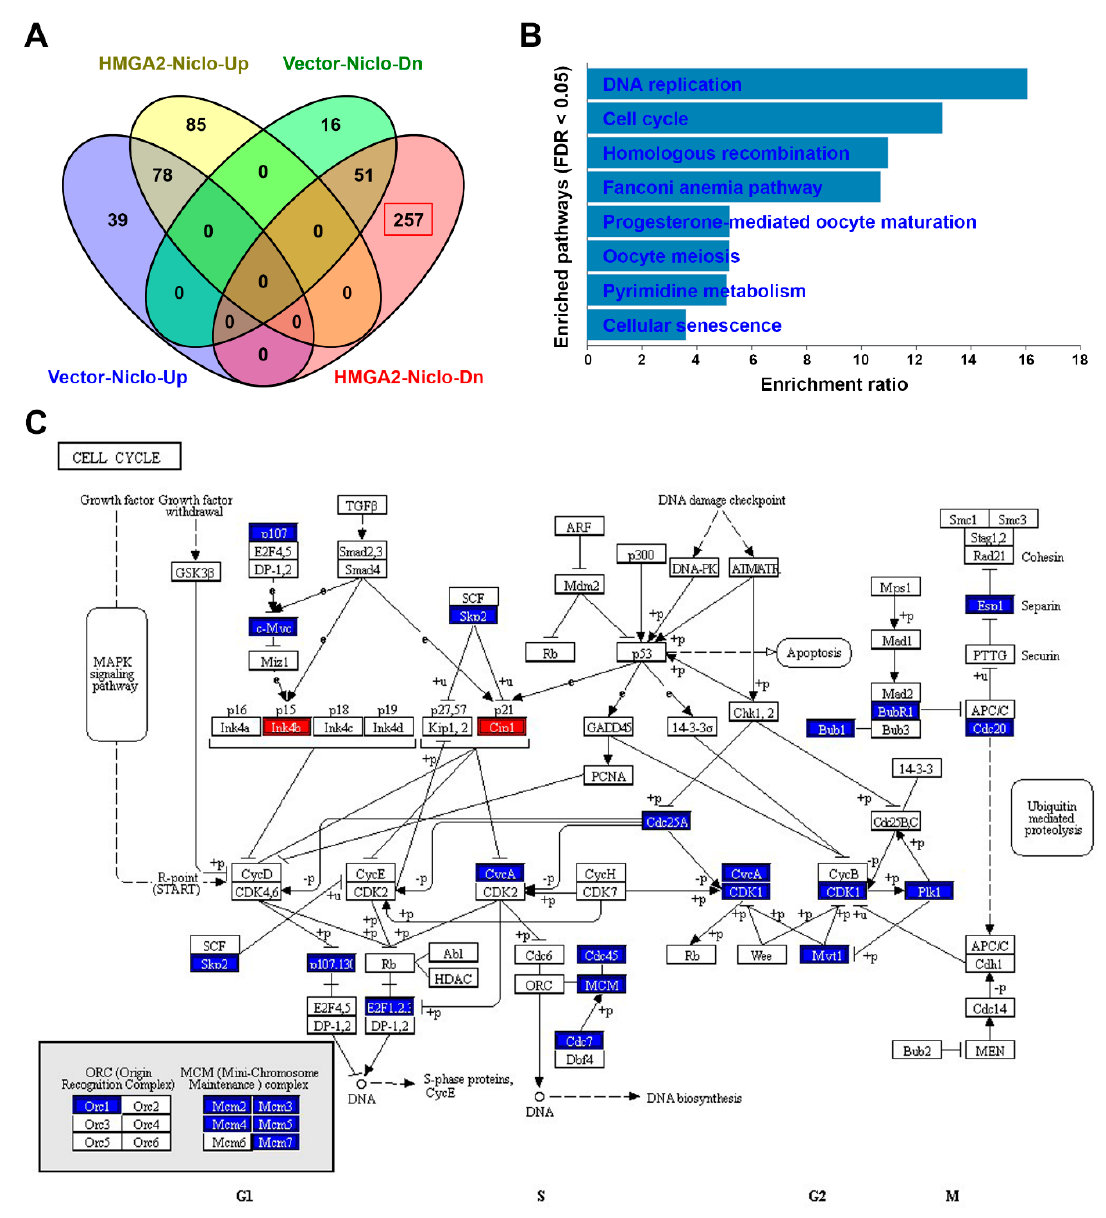
Figure 9. Pathway enrichment for niclosamide-treated cells. ( A ) A Venn diagram showed the numbers of overlapped genes in niclosamide-treated DLD-1-Vector and DLD-1-HMGA2 cells; ( B ) the pathway enrichment results for the downregulated genes in niclosamide-treated DLD-1-HGMA2 cells; ( C ) the mapping of cell cycle pathway for the upregulated (red) and downregulated (blue) genes in niclosamide-treated DLD-1-HGMA2 cells.